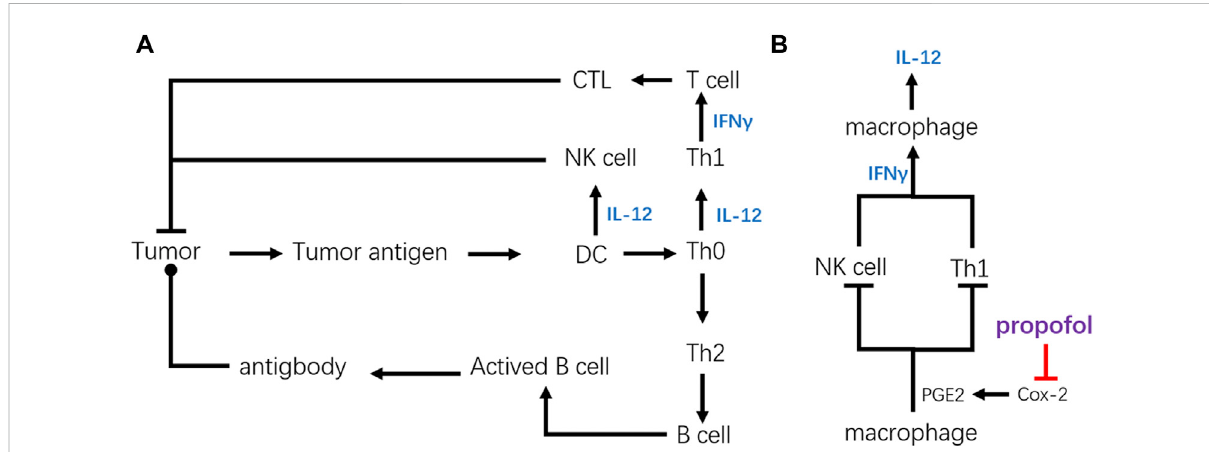
FIGURE 3 Structural diagramoftumor immunityand keyregulatingpoint ofpropofol. (A) Simpli fi edframe oftumor immunity. (B) Keypoint ofpropofol to promoteanticancerimmunity.ByinhibitingthesecretionofPGE2,propofolcanupregulateanticancerimmunityofCTLandNKcells via upregulating cytokines like IFN- γ and